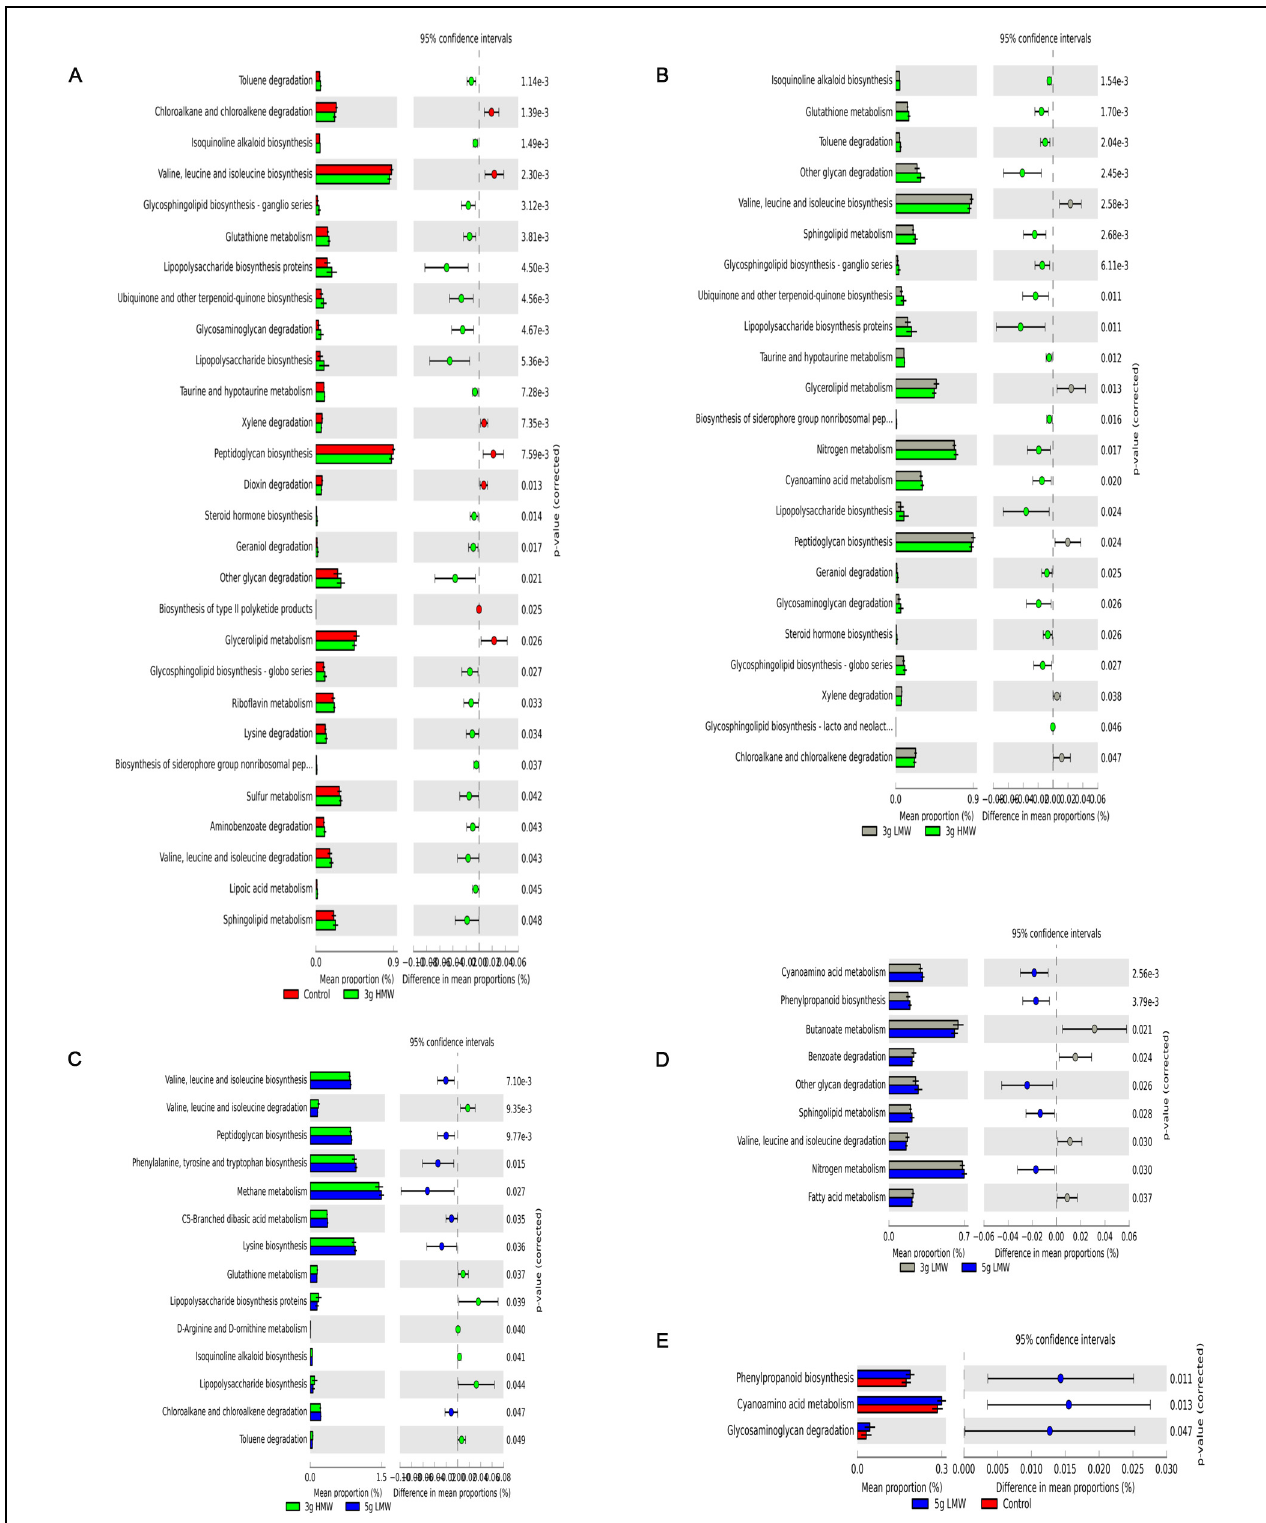
FIGURE 3 | Fold change in the number of 16S rRNA sequences annotated to KEGG level 3 orthologies representing the predicted metabolic capacity of the gut microbiome. (A) 3 g HMW compared to control diet, (B) 3 g HMW compared to 3 g LMW diet, and (C) 3 g HMW compared to 5 g LMW diet, (D) 3 g LMW compared to 5 g LMW diet, and (E) 5 g LMW compared to control diet.